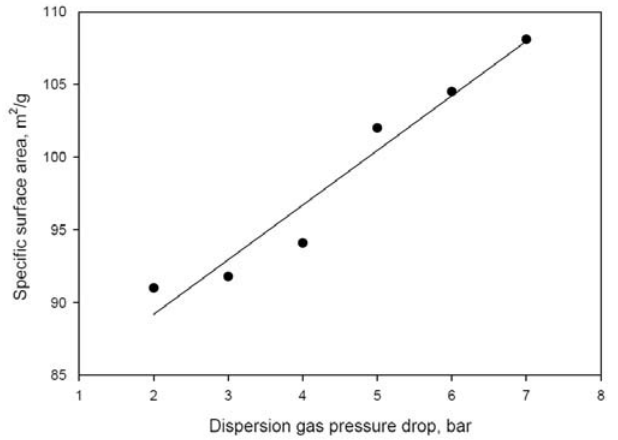
nanoparticles as a function of the dispersion gas pressure drop at constant liquid Fig. 3 Specific surface area of FePO 4 and dispersion gas mass flow rates. Increasing the dispersion gas pressure increases the particle specific surface area and decreases their